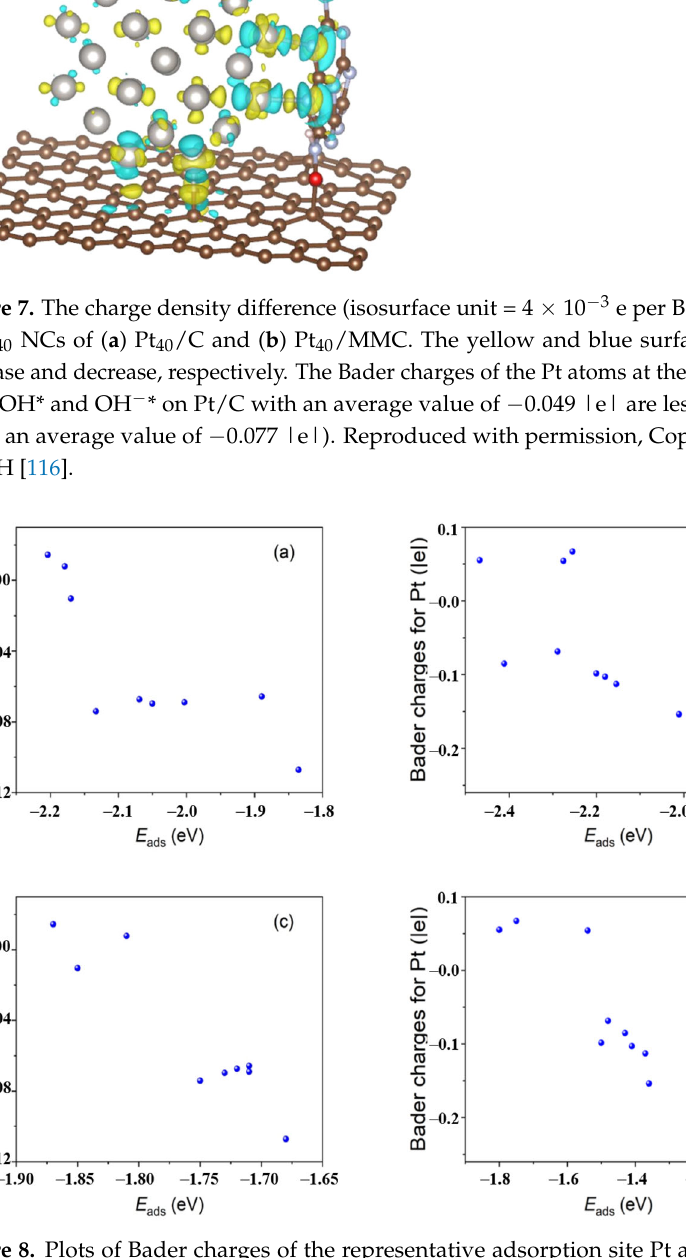
Figure 8. Plots of Bader charges of the representative adsorption site Pt atoms versus adsorption energies of OOH* on Pt 40 NCs of Pt 40 /C ( a ) and Pt 40 /MMC ( b ); plots of Bader charges of the representative adsorption site Pt atoms versus adsorption energies of OH − * on Pt 40 NCs of Pt 40 /C ( c ) and Pt 40 /MMC ( d ). Reproduced with permission, Copyright 2022 Wiley-VCH GmbH [116] .